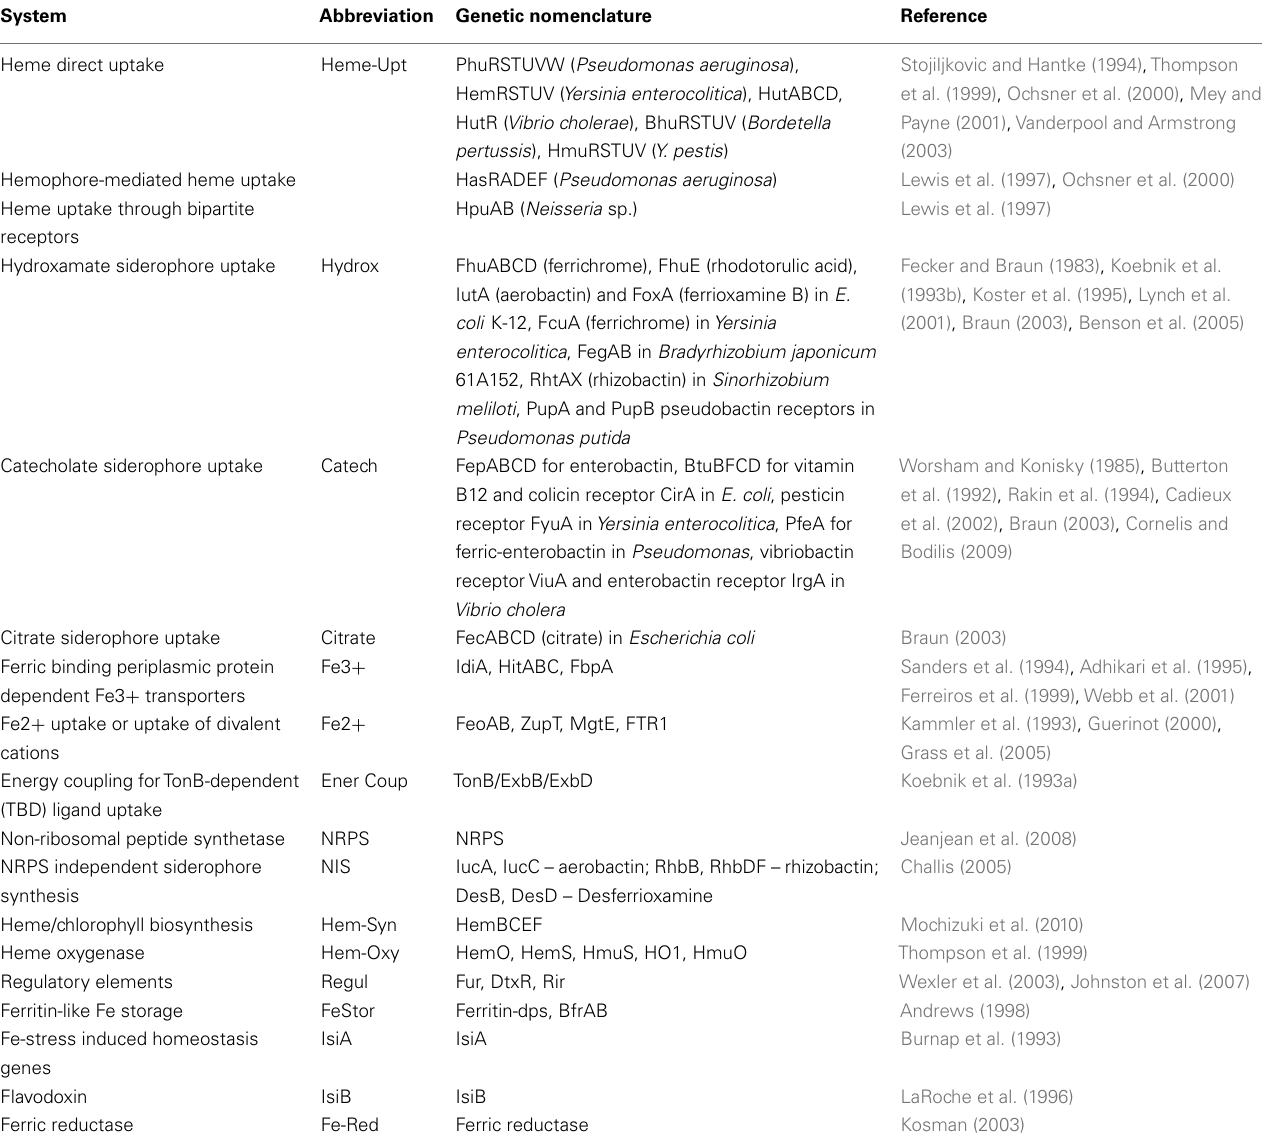
Table 1 | List of proteins involved in Fe-ligand (siderophore and heme) uptake, siderophore, and heme biosynthesis and Fe homeostasis in